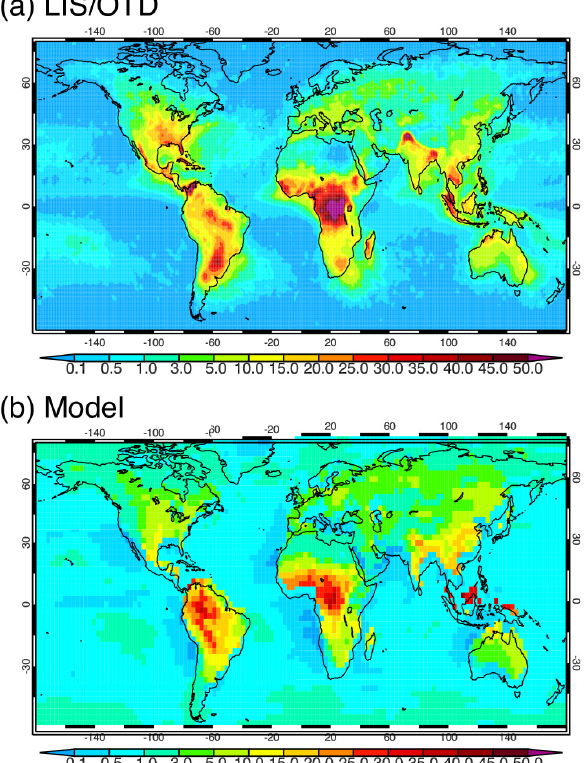
Fig. 2. Global distributions of the mean annual flash rate (in flashes km − 2 yr − 1 ) estimated from (a) the LIS/OTD high-resolution monthly climatology (HRMC) data (Cecil et al., 2014) and (b) the model simulation for